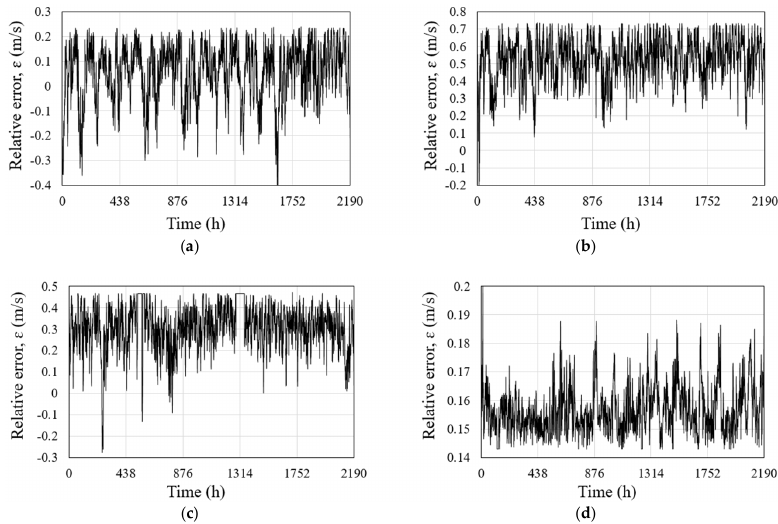
Figure 6. Season-wise estimation of relative error in the predicted wind speed at the test site for the year 2015: ( a ) Winter; ( b ) Spring; ( c ) Summer; ( d ) Autumn.